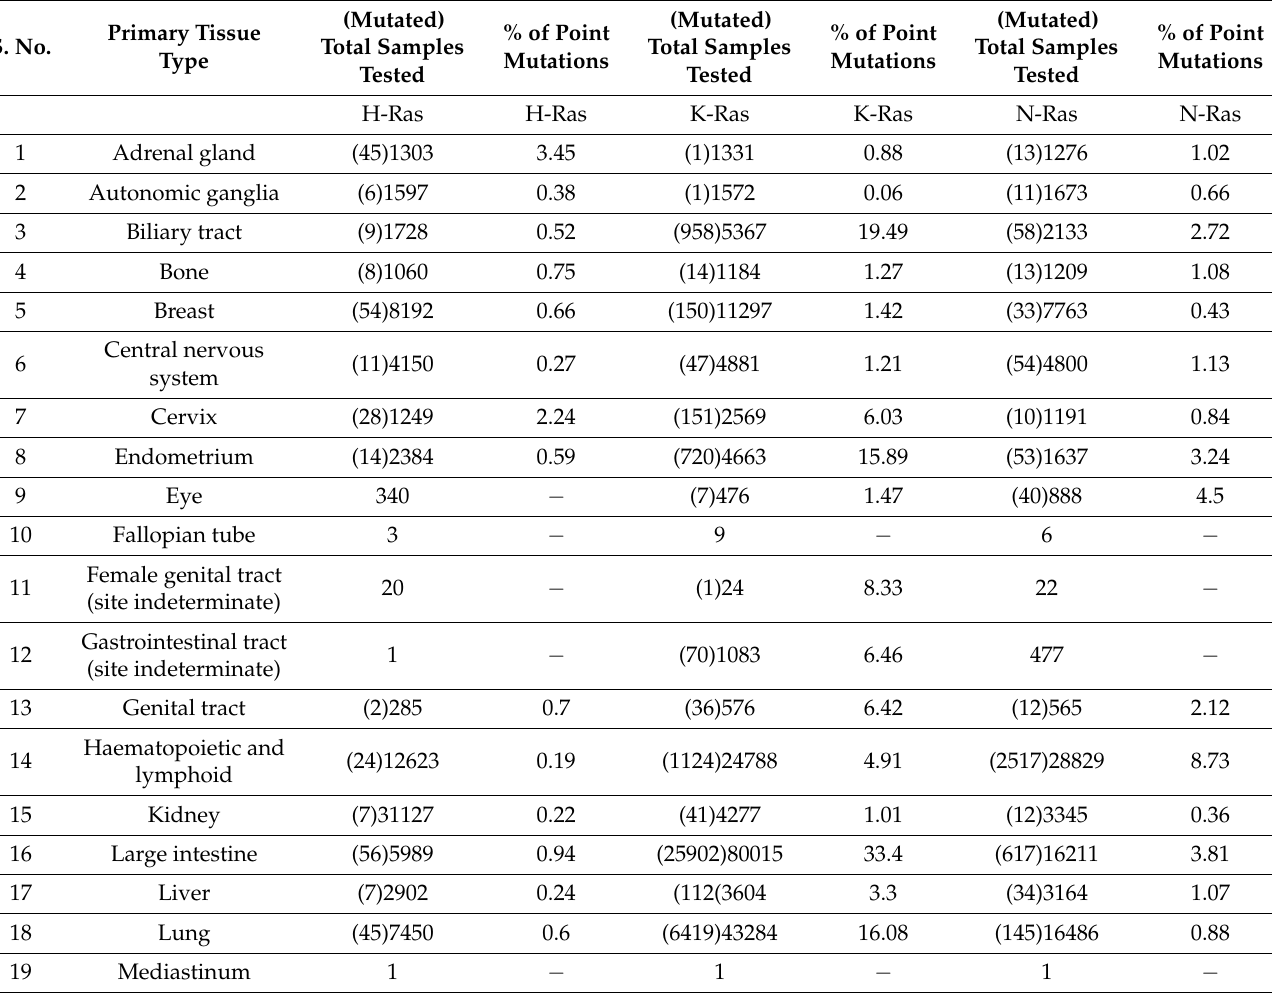
Table 1. The table has been compiled using data from COSMIC v92 (Catalog Of Somatic Mutations In Cancer by Sangers Institute (https://cancer.sanger.ac.uk/cosmic, accessed on 13 June 2021)).